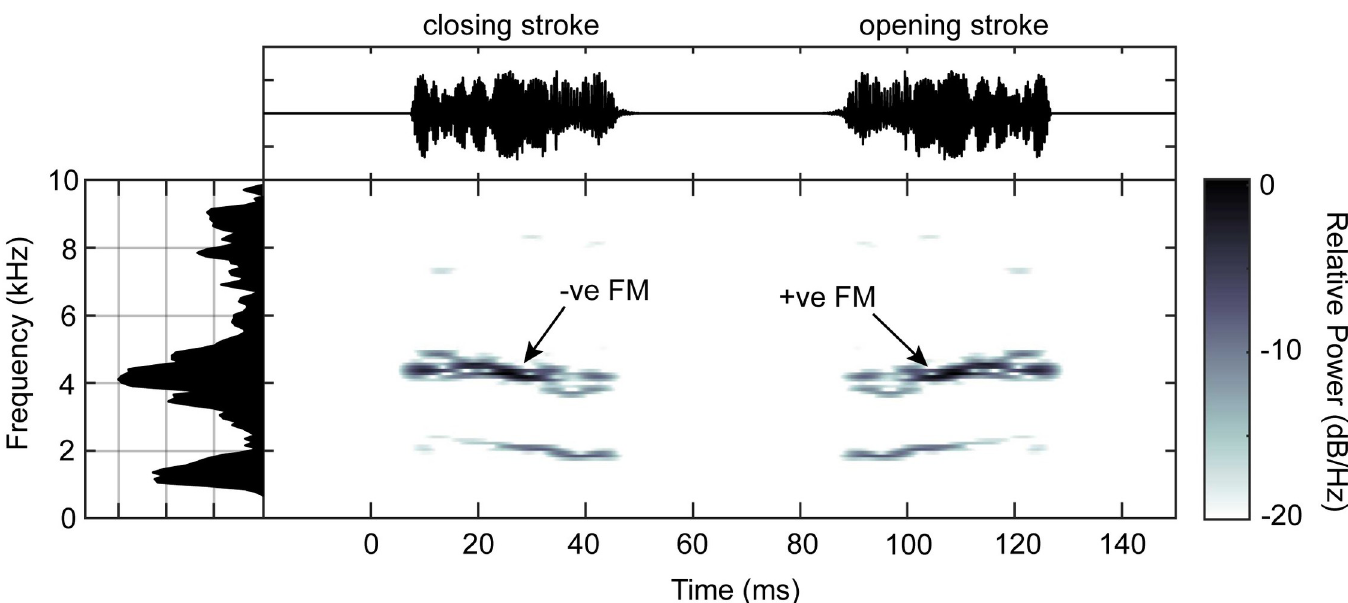
Fig 4. Reconstruction and spectral analysis of a diplo-syllable containing two pulses of the sound of Prophalangopsis obscura . Waveform of two chirps (top), with spectrogram below and frequency spectrum on the left marginal axis. The 2 nd chirp is an artificial reversal of the 1 st chirp, to demonstrate that frequency modulation (FM) will differ depending on whether sound is produced during the opening or closing wing